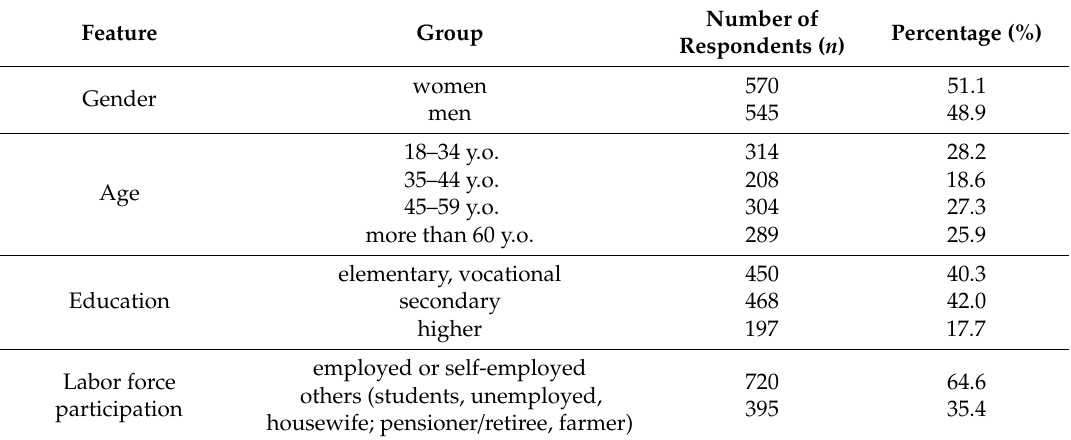
Table 1. Sociodemographic characteristics of the respondents ( n =